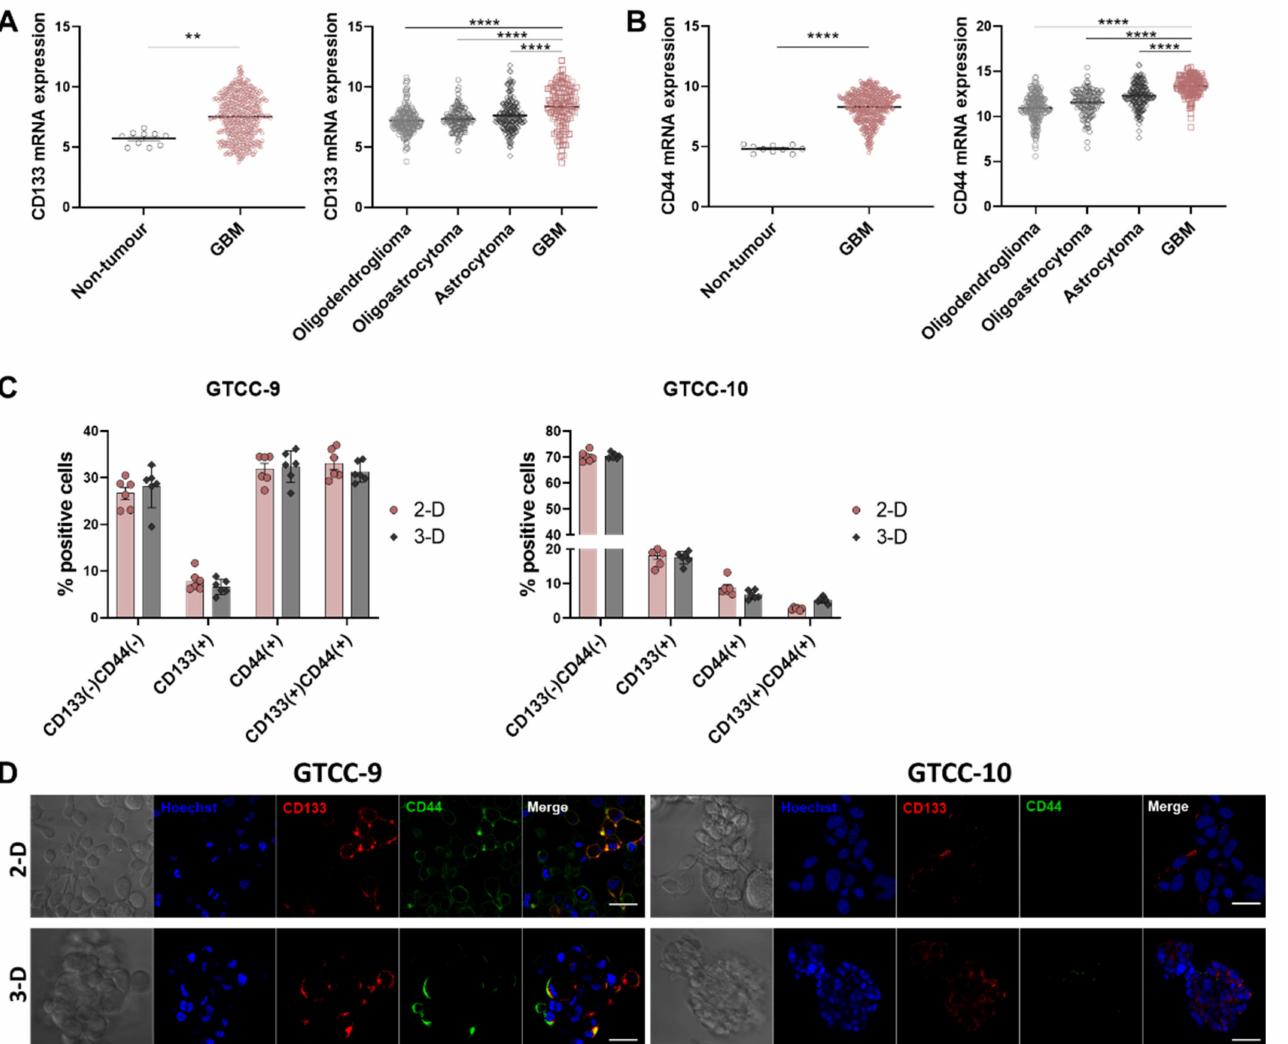
Figure 1. CD133 and CD44 GSC biomarkers are upregulated in GBM. ( A ) Expression of CD133 stem cell marker in the TCGA-GBM dataset. Two-tailed unpaired t -test was used to test for significance, whereby ** p < 0.01 (left panel). Expression of CD133 stem cell marker in the TCGA-LGG-GBM dataset. Two-way ANOVA with post-hoc Tukey’s analysis was used for statistical analysis, whereby, **** p < 0.0001 (right panel). ( B ) Expression of CD44 stem cell marker in the TCGA-GBM dataset. Two-tailed unpaired t-test was used to test for significance, whereby **** p < 0.0001 (left panel). Expression of CD44 stem cell marker in the TCGA-LGG-GBM dataset. Two-way ANOVA with post-hoc Tukey’s analysis was used for statistical analysis, whereby, **** p < 0.0001 (right panel). ( C ) CD133 and CD44 expression in recurrent monolayer (2-D) and gliomasphere (3-D) cultures was assessed using flow cytometry. Data are expressed as mean ± SEM. n = 6 independent experiments performed in triplicate. ( D ) Confocal microscopy was used to assess the expression of CD133 and CD44 stem cell markers in GTCC-9 (left) and GTCC-10 (right) cultures in 2-D and 3-D culturing conditions; representative images are shown here; scale bar = 50 µ